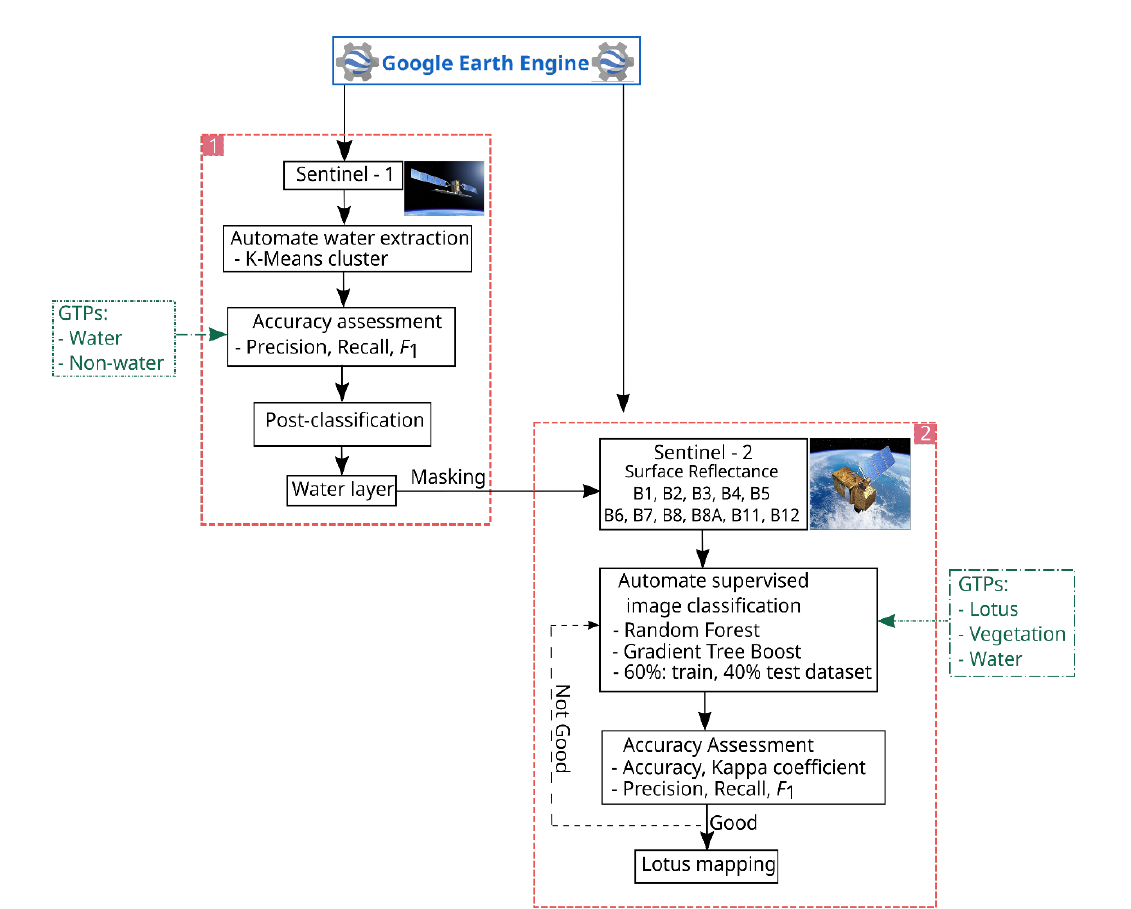
Figure 2. Proposed workflow of water extraction and lotus mapping from satellite image data.